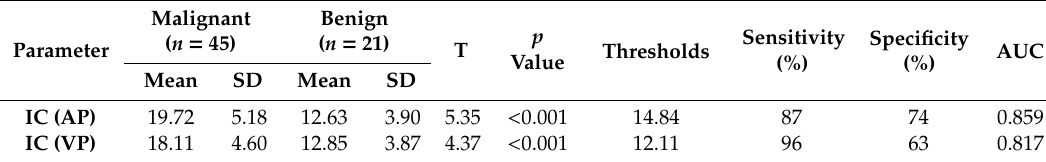
Table 3. Student’s t -test. Analyses of di ff erences in IC maps between the malignant and benign nodules.